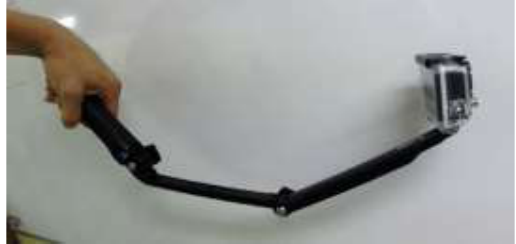
Figure 1: GoPro mounted on GoPro Extender Handle.